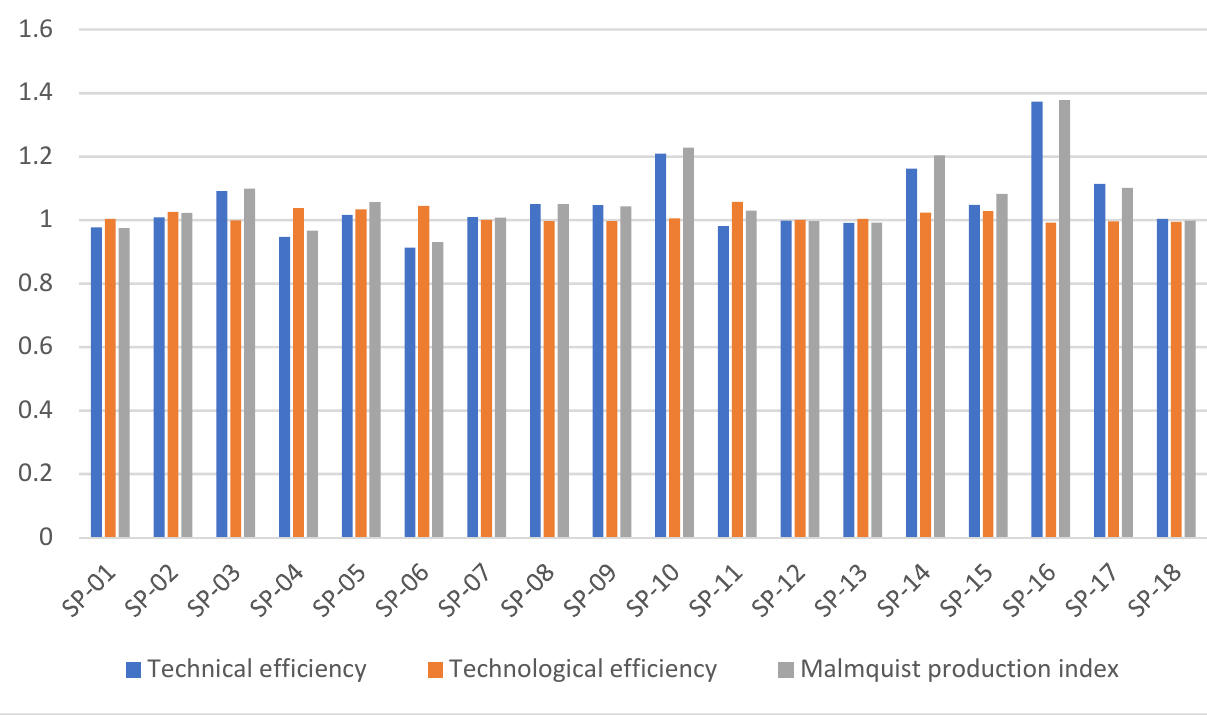
Figure 5. Comparison of average efficiency indexes.